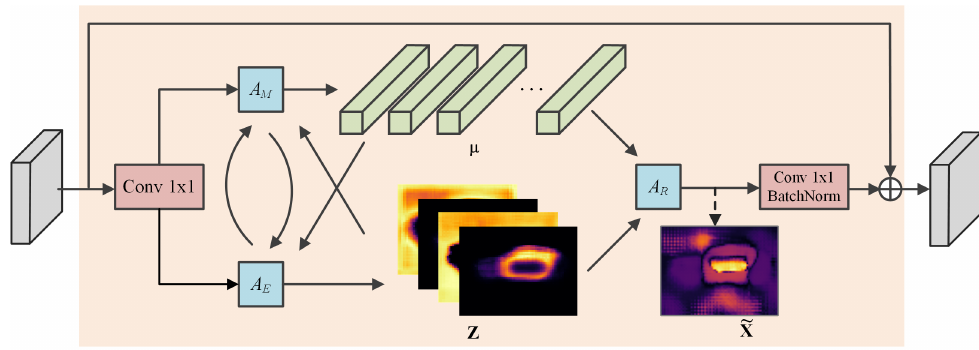
Figure 5. Detailed structure of an expectation maximization attention unit.